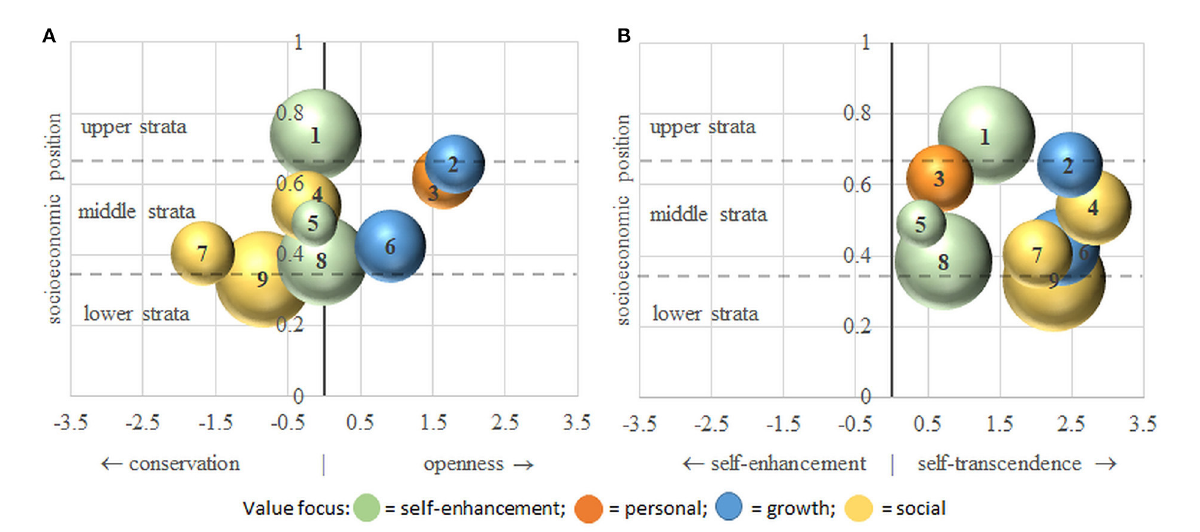
FIGURE3 A new model of social milieus: Latent Class Analysis of socioeconomic position and basic human values. Source: ESS8, 2016, n = 2,470, own calculations. The social milieus’ socioeconomic positions are plotted against the value axis from conservation to openness (panel A) , and the value axis from self-enhancement to self-transcendence (panel B) . Milieus with similar value foci are assigned the same